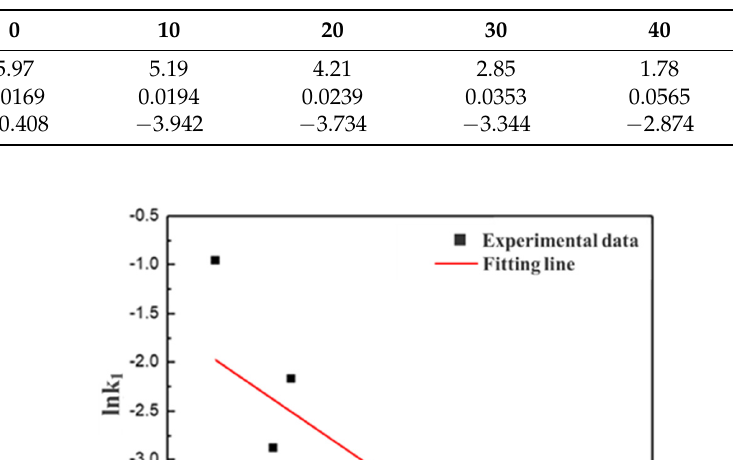
Table 8. The C content in the melt at different times and the calculated rate constants k 1 and ln k 1 .